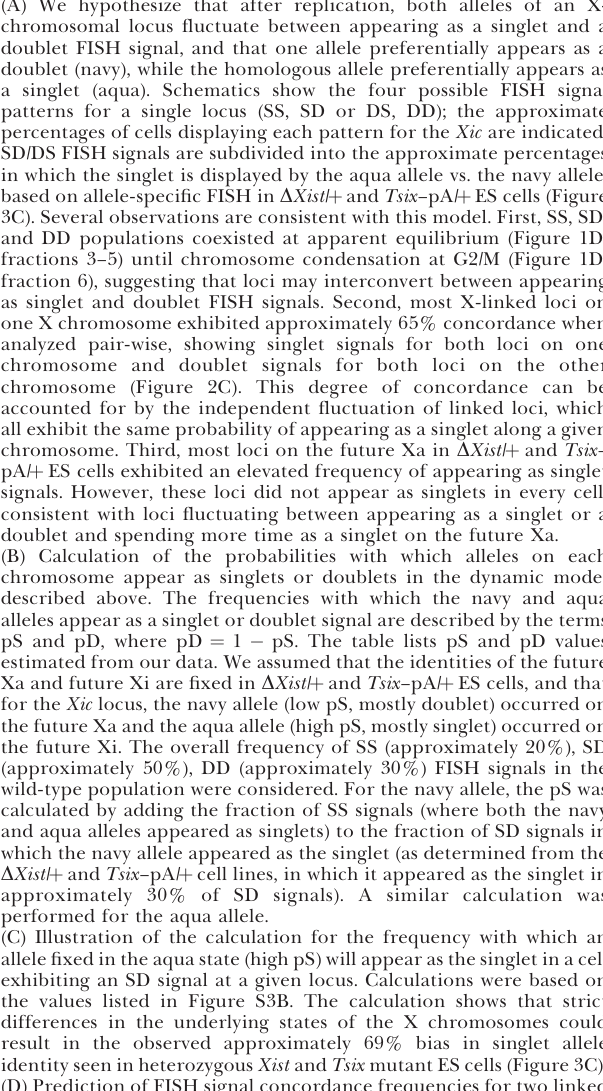
Figure S2. Allele-Specific FISH for the Xic (red) in 129-tet/ cas ES Cells for the Experiment Scored in Figure 4C Shown are the two classes of SD cells in which the 129-tet allele, identified using a tet-operator probe (green; yellow overlap, indicated bywhitearrowheads),appearsasthesinglet(left)orthedoublet(right). Found at DOI: 10.1371/journal.pbio.0040159.sg002 (269 KB PPT). Figure S3. A Dynamic Model for SIAR